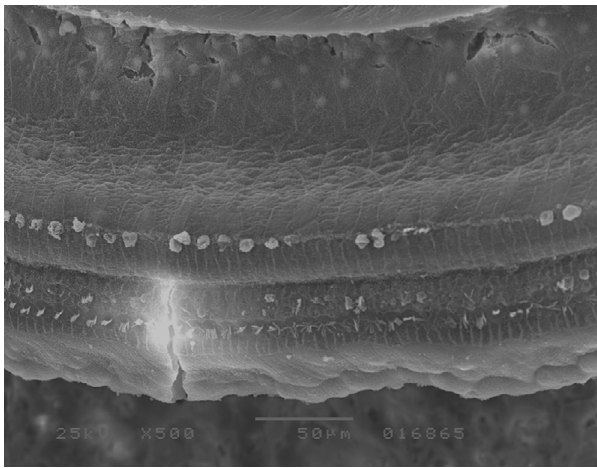
Figure 4 Photo from Cont group (scanning electronic microscopy), 500 × magnification.